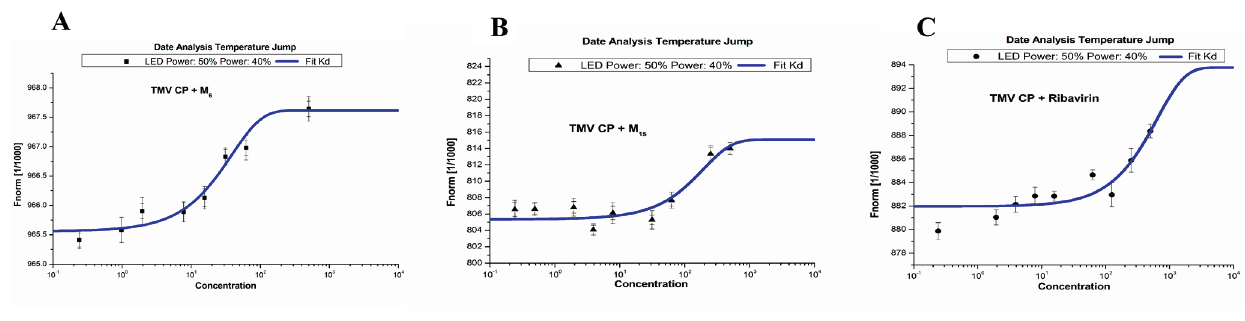
Figure 3. Microscale thermophoresis (MST) of M Table 4. The dissociation constant of M